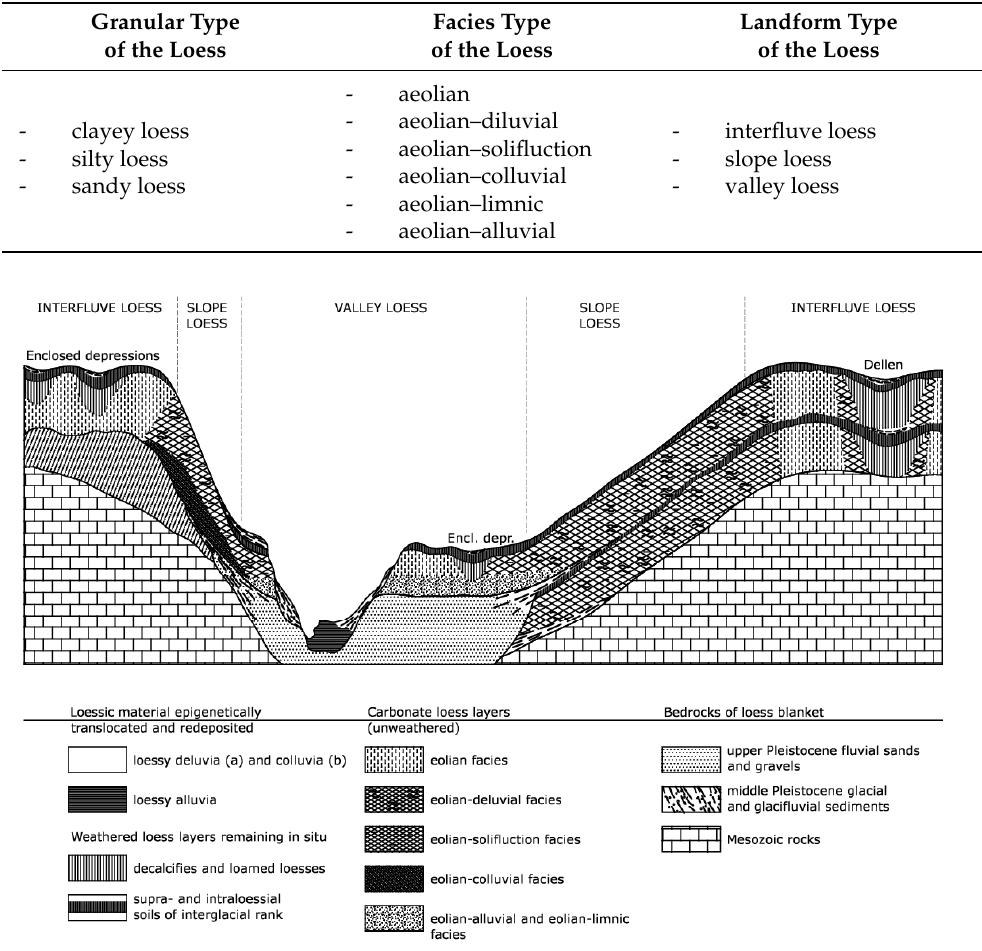
Figure 1. Ideogram of the facial–genetic division of loess